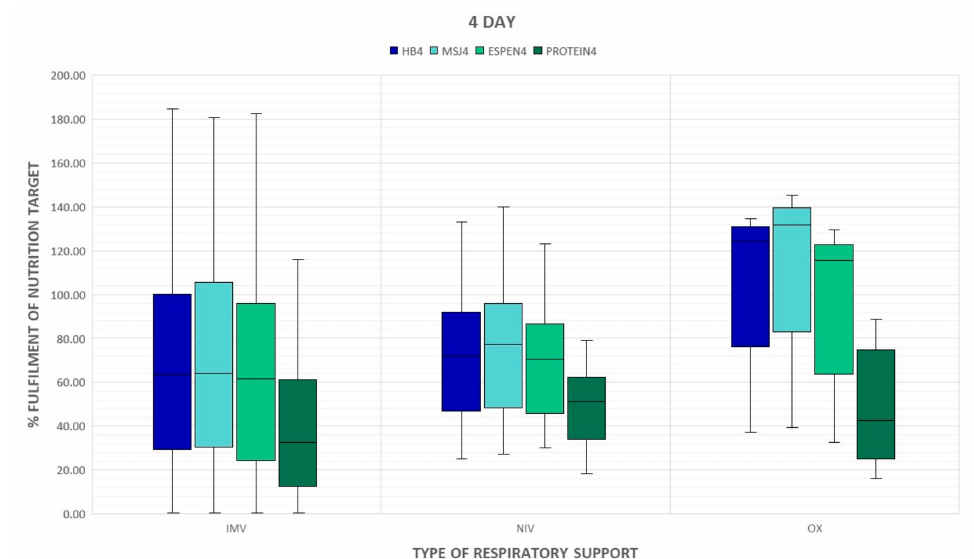
Figure 1. Type of respiratory support at the ICU admission and delivery of energy and proteins on